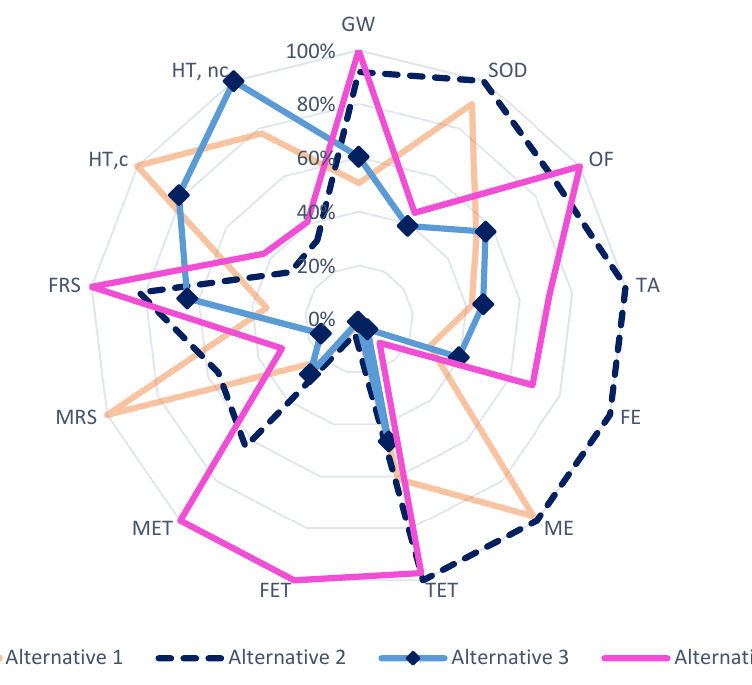
Figure 6. Comparative analysis of the starch bioadhesives alternatives.